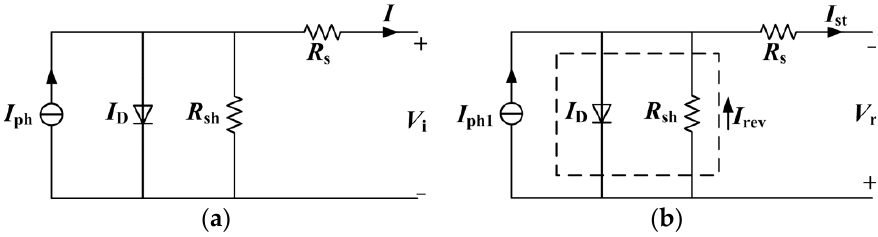
Figure 2. Photovoltaic cell single-diode model: ( a ) normal photovoltaic cell; ( b ) hot spot cell.